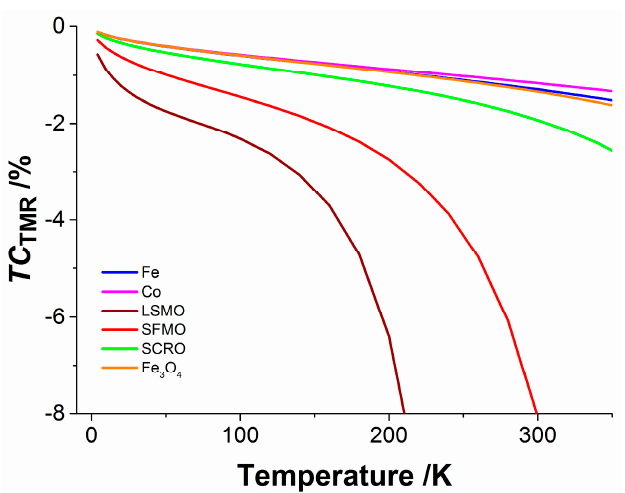
Figure 3. Temperature dependence of the temperature coefficient TC TMR of the TMR calculated by means of Equation (10).